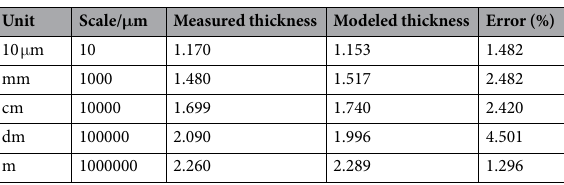
Table 1. Modeled and measured thicknesses of layers at